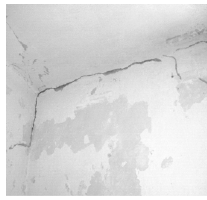
Fig. 10. Cracked wall in a hermitage